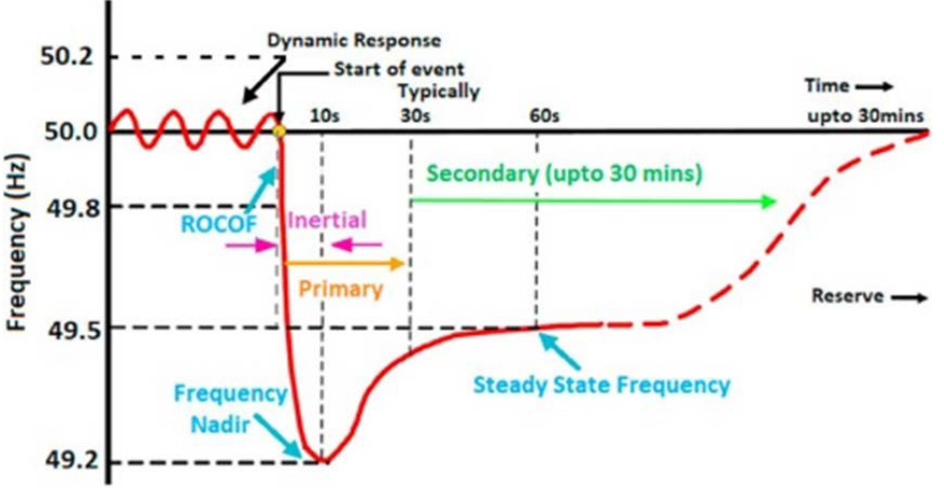
Figure 1. Frequency control following a power disturbance [5].